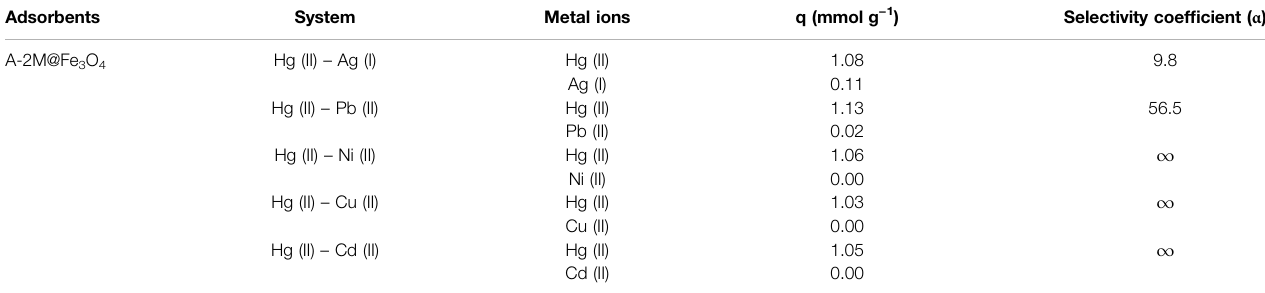
TABLE 6 | The adsorption selectivity of bifunctional PSQ/CNTs magnetic composites for Hg(II).